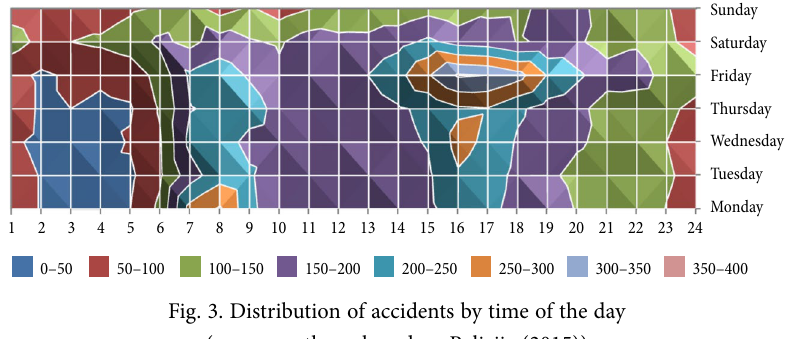
Fig. 3. Distribution of accidents by time of the day (source: authors, based on Policija (2015))